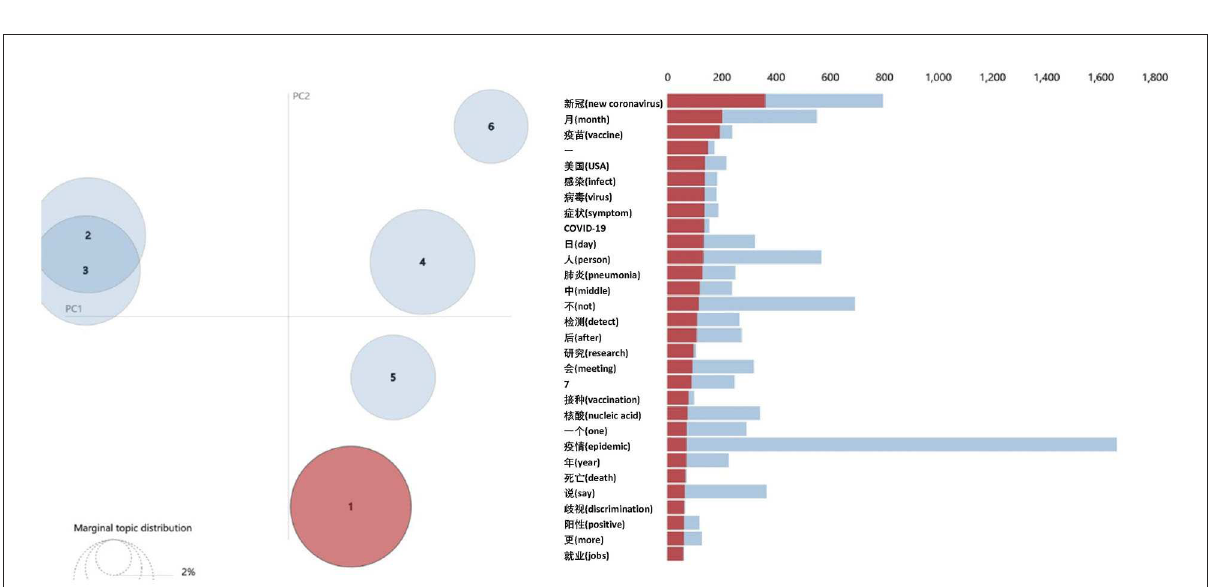
FIGURE11 The pyLDAvis visualization results for disgust microblogs (topic number